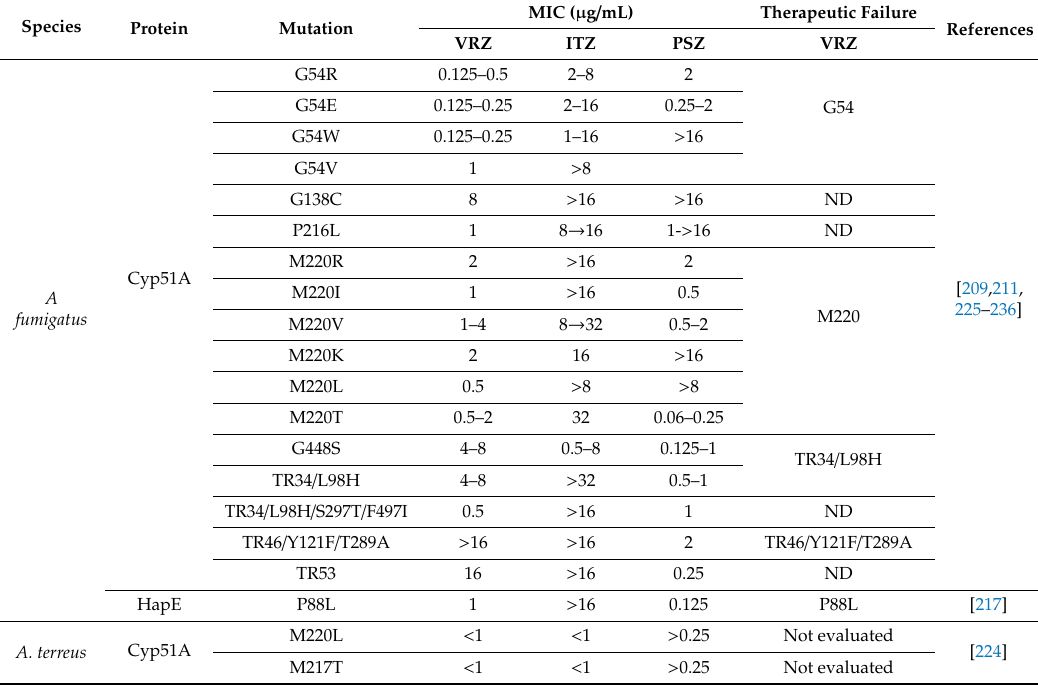
Table 3. Mutations involved in azole resistance in A. terreus and A. fumigatus and their in vitro and in vivo impacts. The frequencies mentioned do not necessarily consider all studies published and might be a rough approximation of the actual